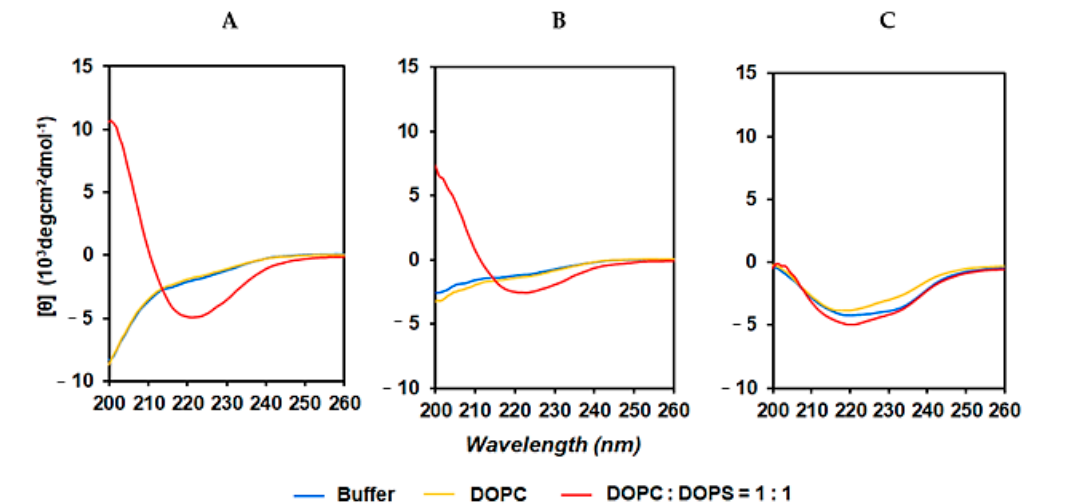
Figure 5. CD spectra of NOTA-CAPs in the presence and absence of liposomes. CD spectra of 150 µ M NOTA-KV6 ( A ), NOTA-RV6 ( B ), and NOTA-HV6 ( C ) in an aqueous buffer solution (50 mM BTP and 150 mM NaF at pH 7.4) (blue line) in the presence of neutral PC liposomes (yellow line) and in the presence of negatively charged DOPC/DOPS liposomes (1:1) (red line).